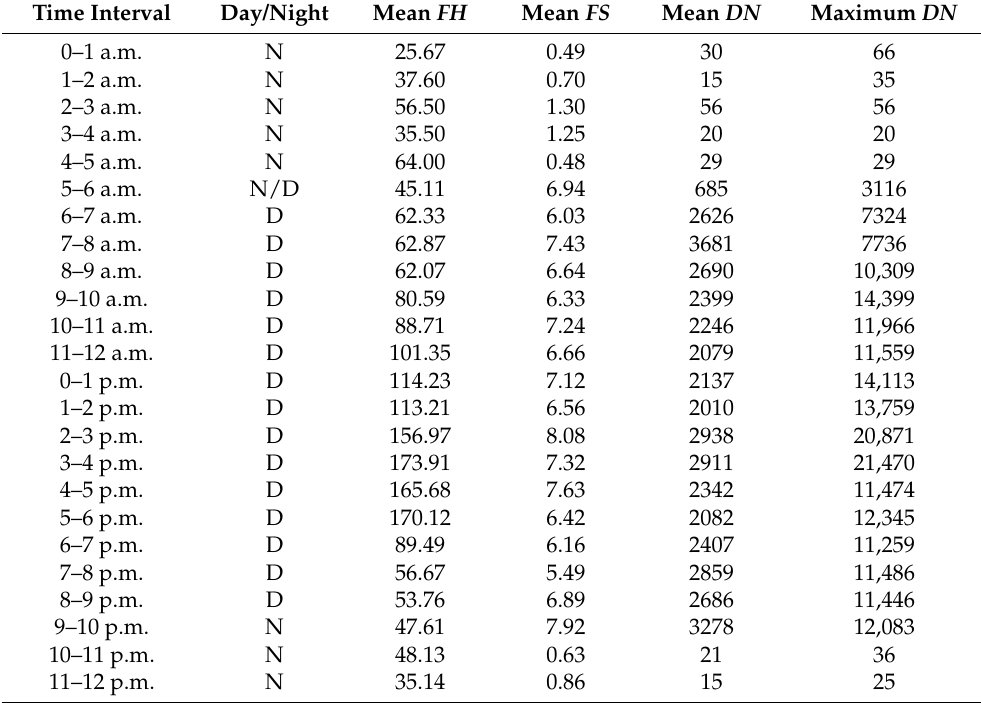
Table 4. Time intervals (local time) and red-footed falcons’ flight attributes using data from all individuals